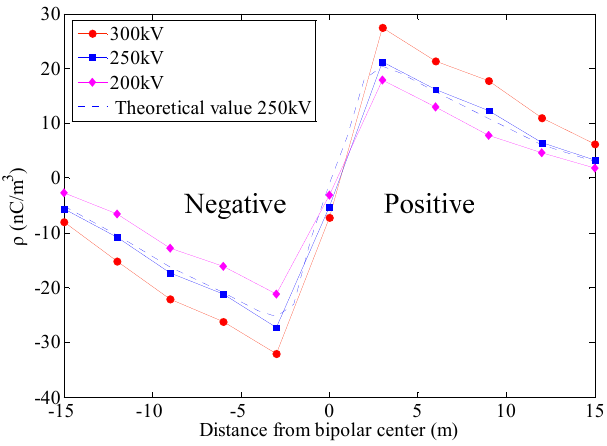
Figure 17. Picture of measurement system used under UHVDC transmission line.